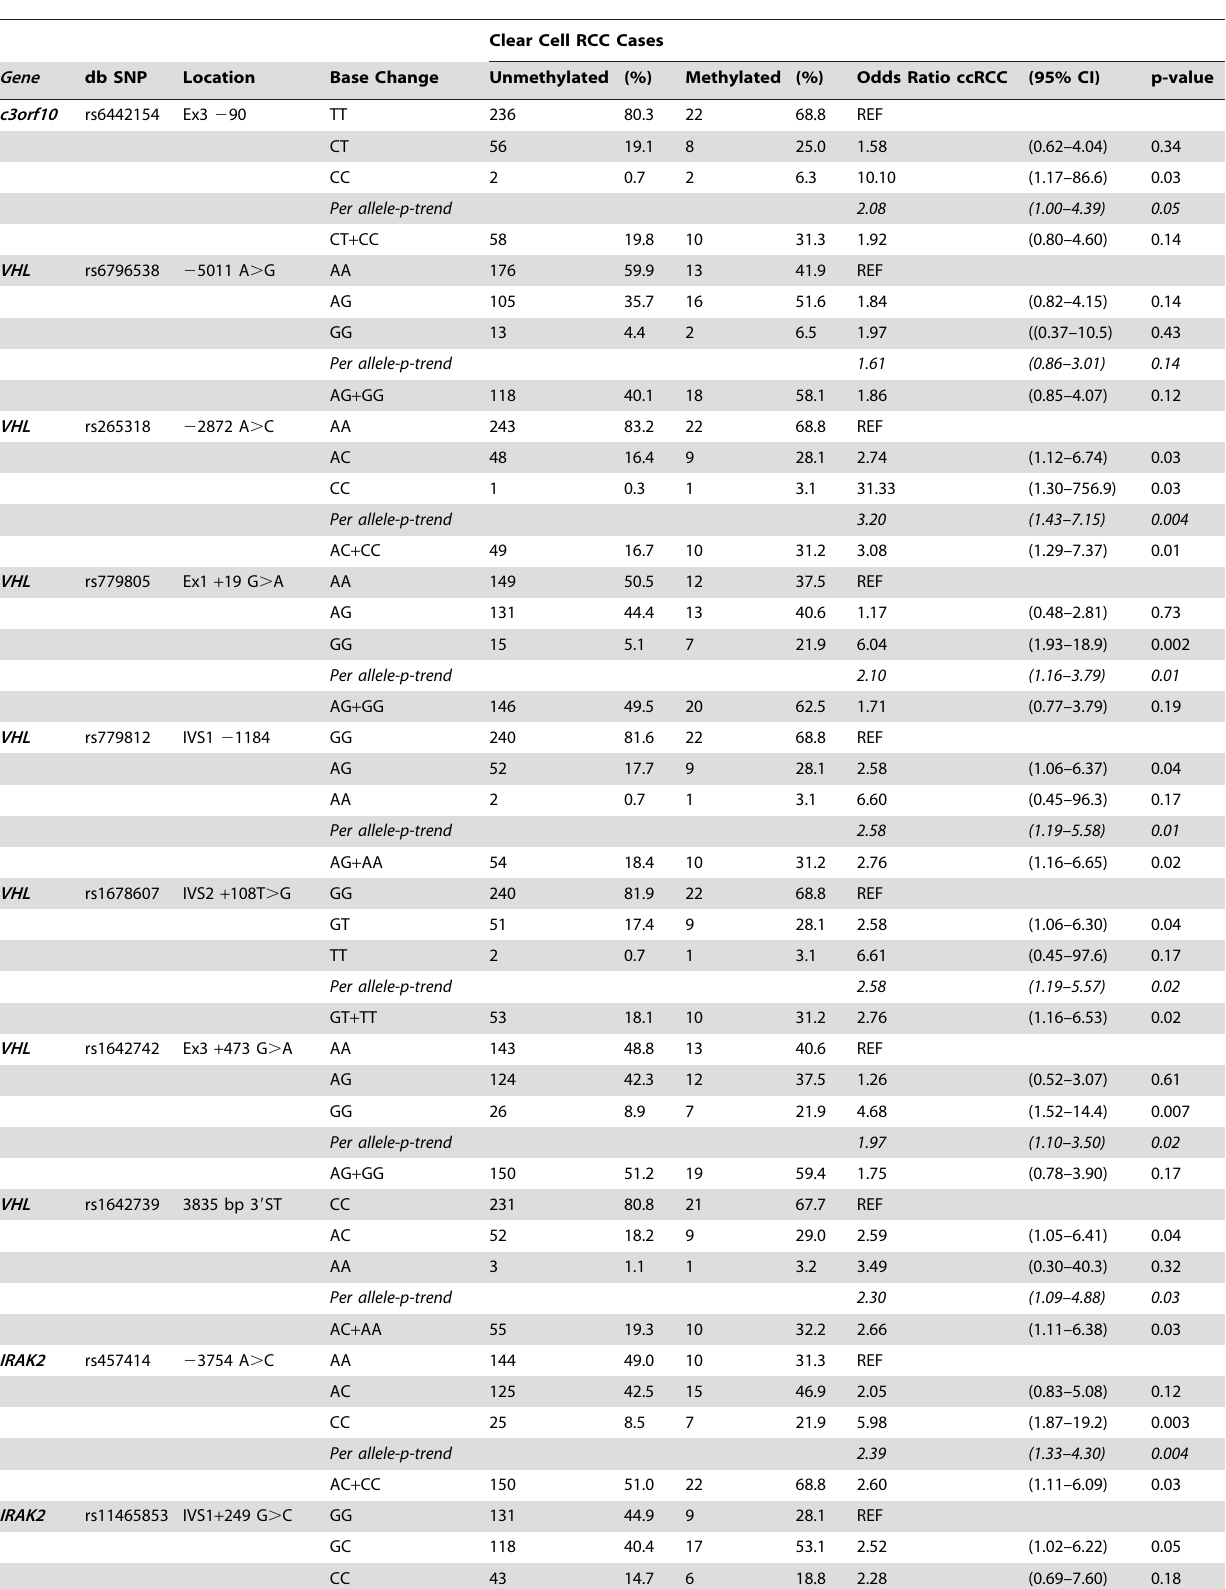
Table 4. Tagging SNP analysis of common VHL polymorphisms in genomic DNA and promoter hypermethylation in somatic tissue from ccRCC